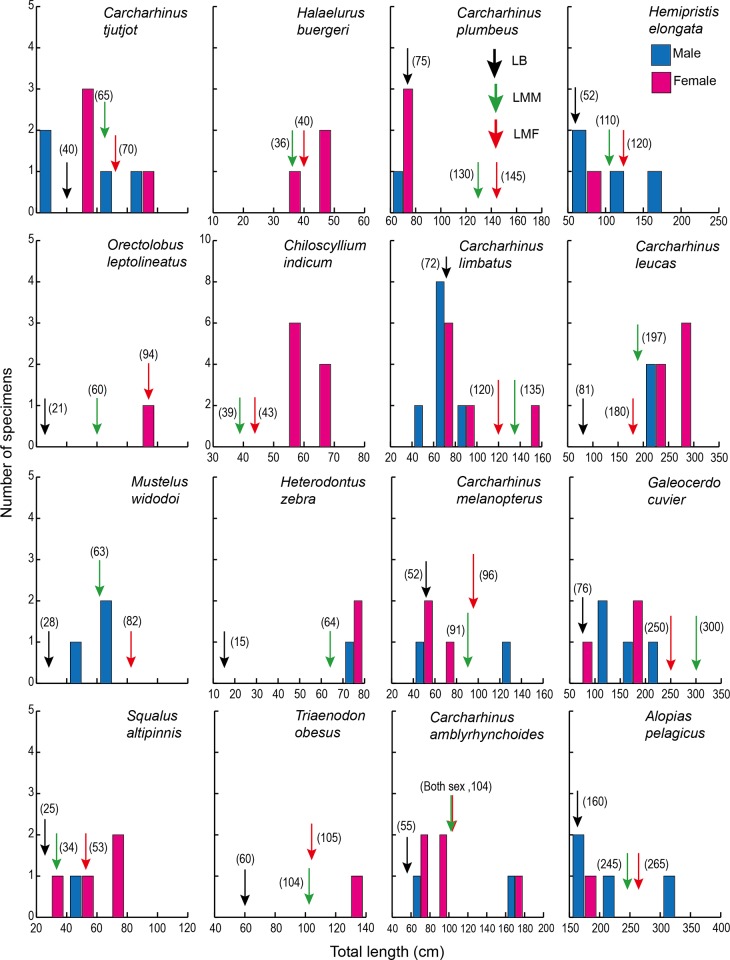
Size distributions of sharks landed in the southern South China Sea.Sixteen shark species with less than 5 specimens were landed at various growth stages from the newborn juveniles and/or to mature adults22-26. LB (black arrow), LMM (green arrow) and LMF (red arrow) indicate the length at birth, length at maturation of male and length at maturation of female, respectively.